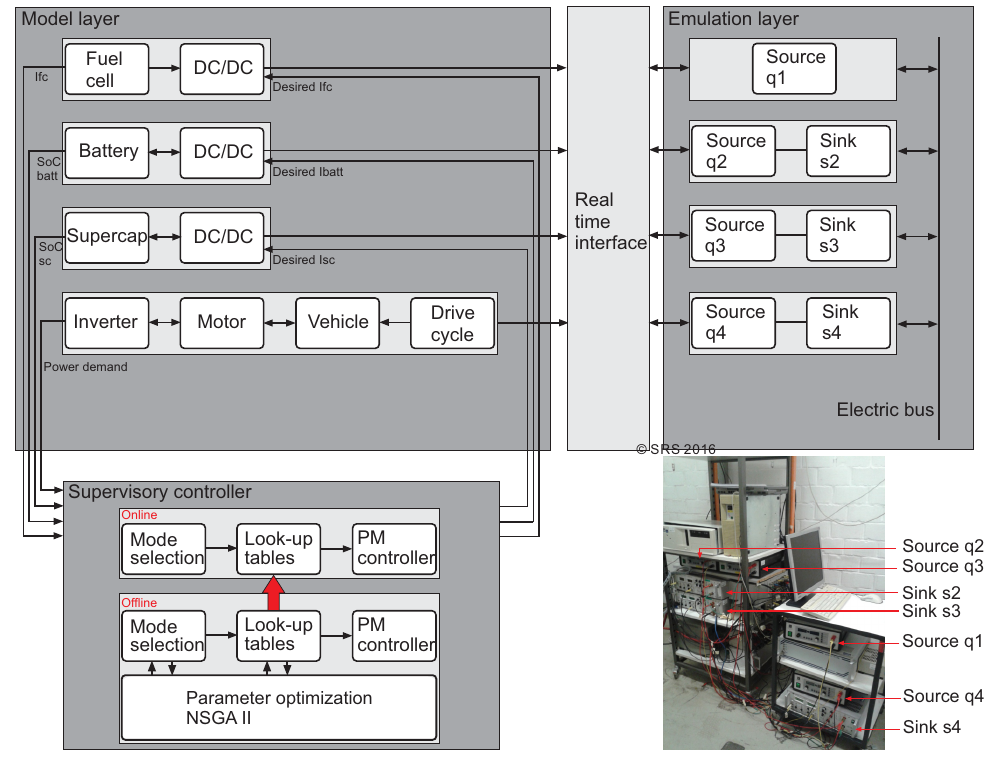
Figure 2. Configuration of an HEV along with the power management optimization. NSGA II, Non-Dominated Sorting Genetic Algorithm